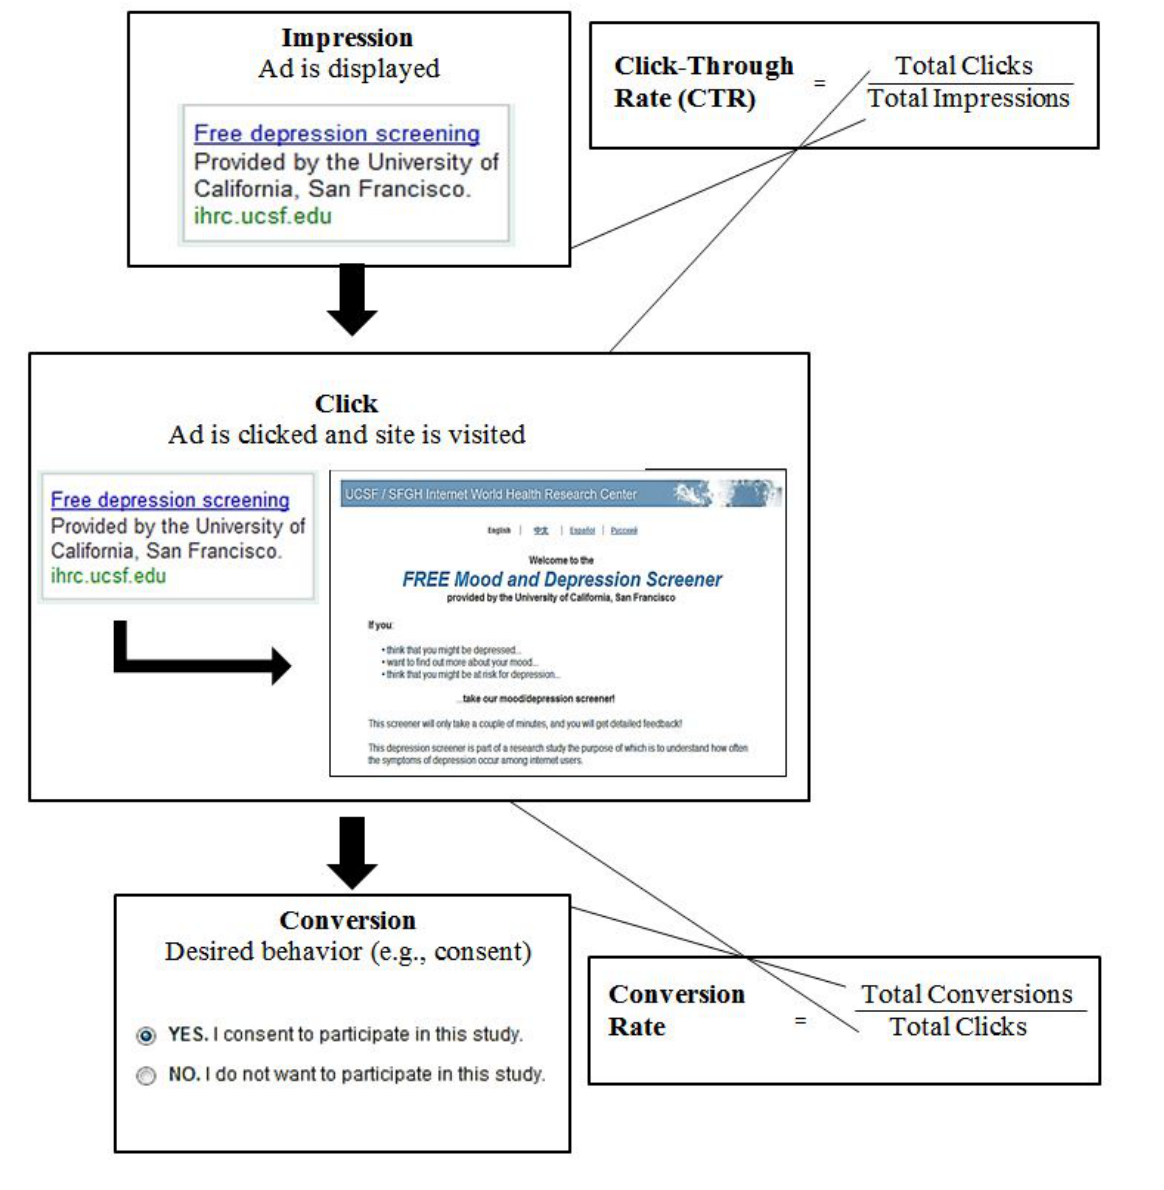
Figure 1. Google AdWords